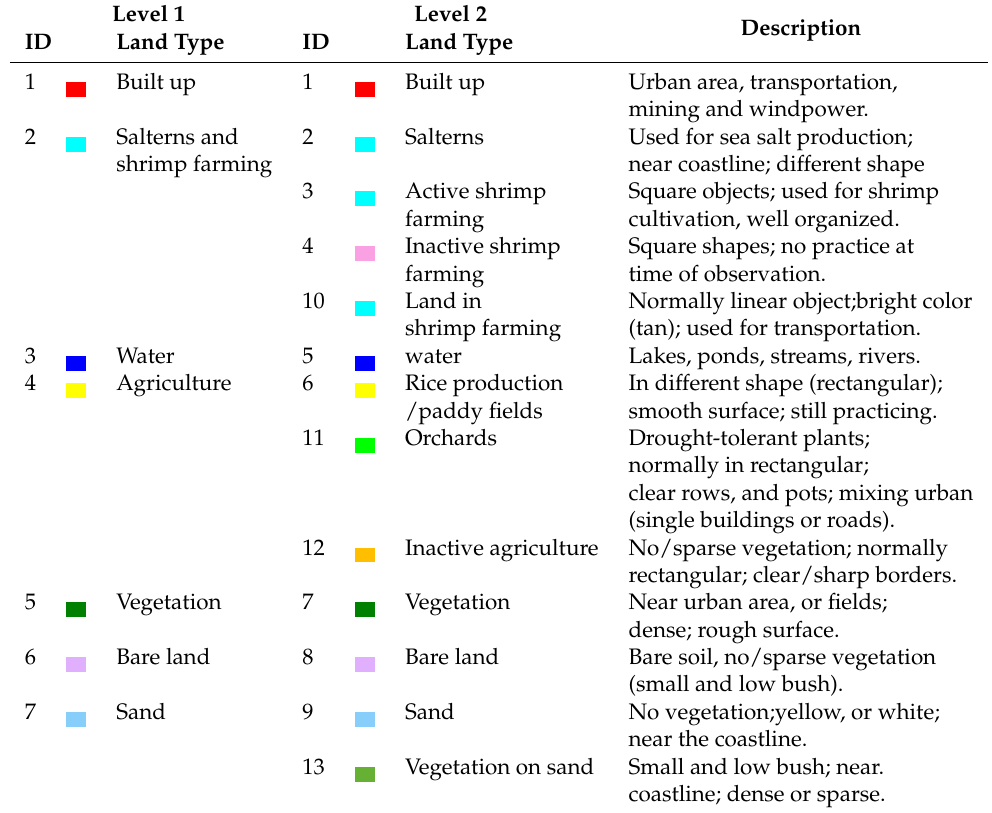
Table 2. Description of land use and land cover categorized system in this research at two detailed